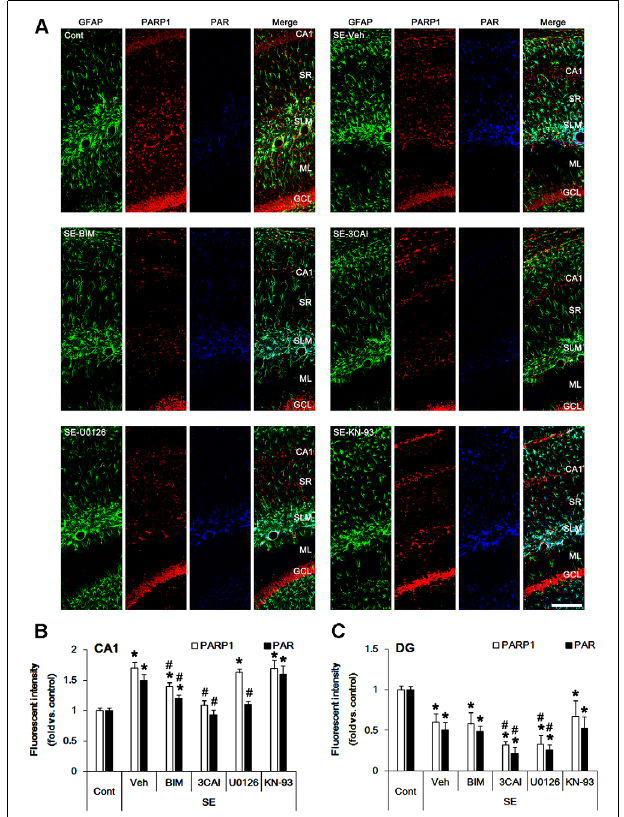
FIGURE 1 | Effect of Status epilepticus (SE) on Poly(ADP-ribose) polymerase-1 (PARP1) expression and PAR level in the hippocampus. SE increases PARP1 expression and PAR level CA1 astrocytes, which are abrogated by BIM and 3CAI. U0126 attenuates the enhanced PAR level without changing PARP1 expression following SE. In contrast, SE diminishes PARP1 expression and PAR level in dentate astrocytes, which are deteriorated by 3CAI and U0126. (A) Representative triple immunofluorescent images for glial fibrillary acidic protein (GFAP), PARP1 and PAR following SE. Bar = 100 µ m. Abbreviations: CA1, CA1 pyramidal cell layer; SR, stratum radiatum; SLM, stratum lacunosum-moleculare; ML, molecular layer; GCL,